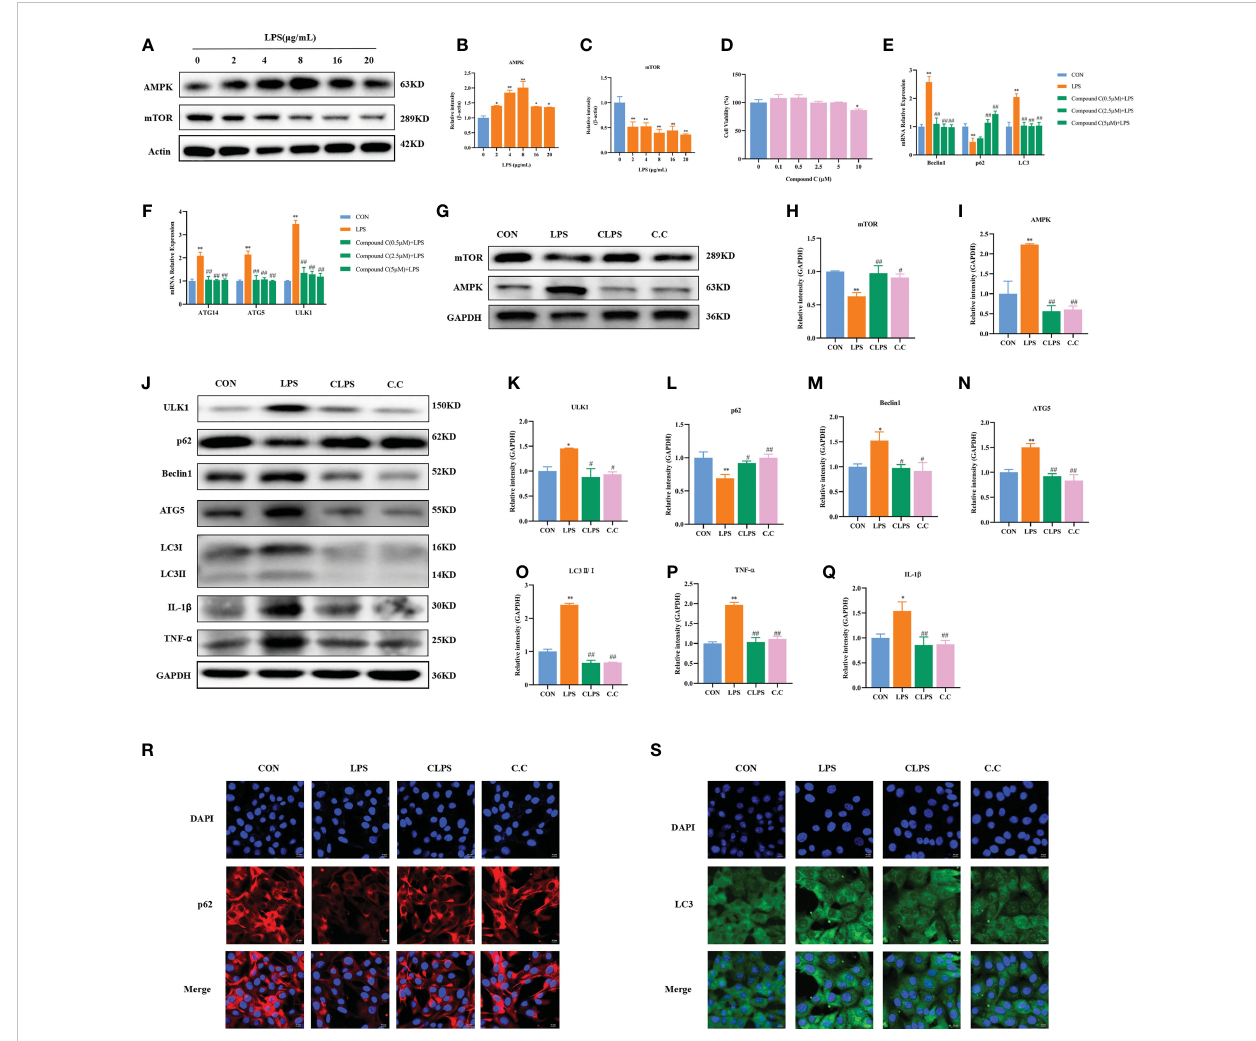
FIGURE 5 Effect of compound C pretreatment on LPS-induced autophagy in BMECs. Western blot representative bands and quantitative result of AMPK and mTOR protein in BMECs treated with different concentrations of LPS for 3 h (A – C) . Effects of compound C on the cell viability of BMECs (D) . Effects of compound C pretreatment with different concentrations on LPS-induced autophagy-related genes in BMECs (E, F) . Effects of compound C pretreatment on AMPK and mTOR proteins (G – I) . Western blot representative bands and quantitative result of autophagy and in fl ammation proteins in BMECs treated with LPS after compound C pretreatment (J – Q) . Immuno fl uorescence results of p62 and LC3 in BMECs treated with LPS after compound C pretreatment (R, S) . Scale bar, 10 m m. * p < 0.05, ** p < 0.01, representing signi fi cant difference compared with Ctrl group; # p < 0.05 and ## p < 0.01, representing signi fi cant difference compared with